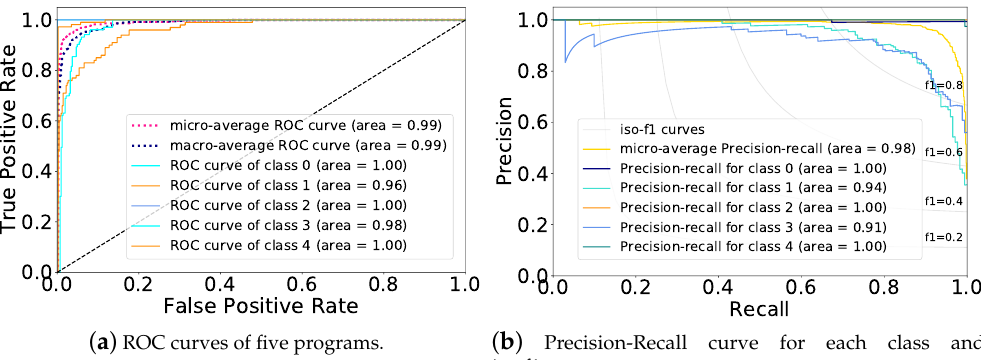
Figure 9. The ROC curves and the Precision-Recall curves of multiclass SVM classification using one-vs-the-rest (OvR) multiclass strategy. Class 0 is the normal program, and class 1 is Attack1, etc. ( a ) ROC curves of five programs; ( b ) Precision-Recall curve for each class and iso-f1 curves.